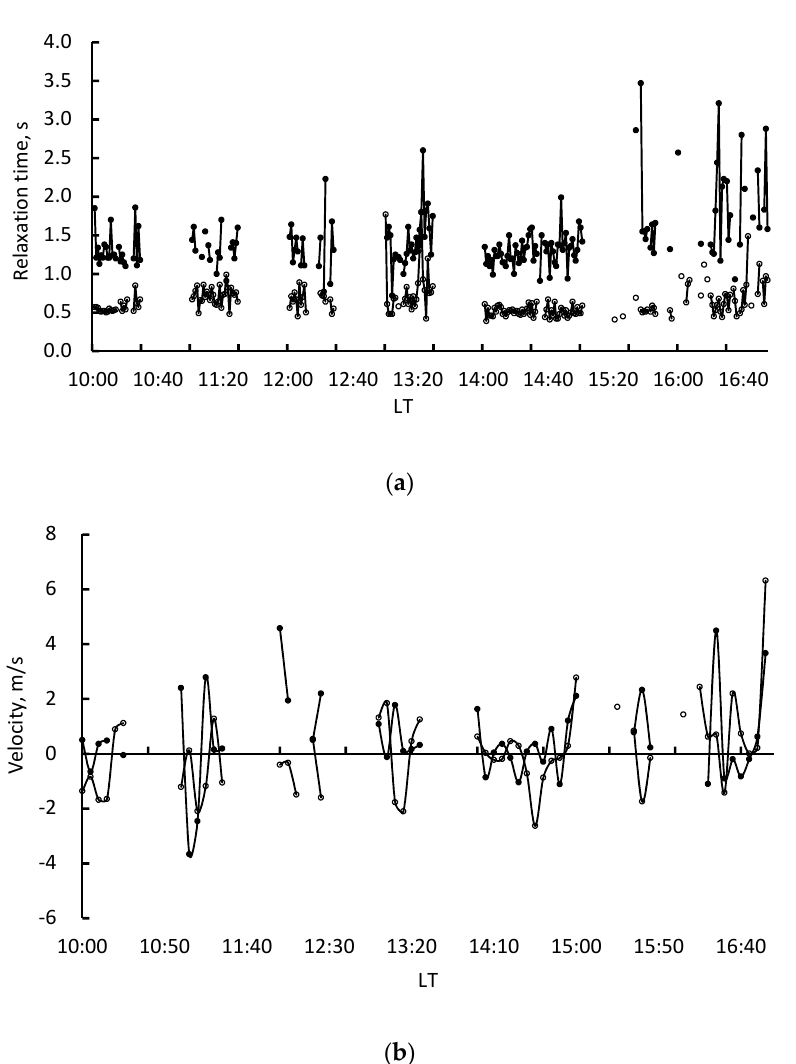
Figure 9. The time dependence of the relaxation time averaged over 1 min ( a ) and the time dependence of the vertical velocity averaged over 5 min ( b ) on heights of 65.8 km (circles) and 75.6 km (points) for 12 September 2019.